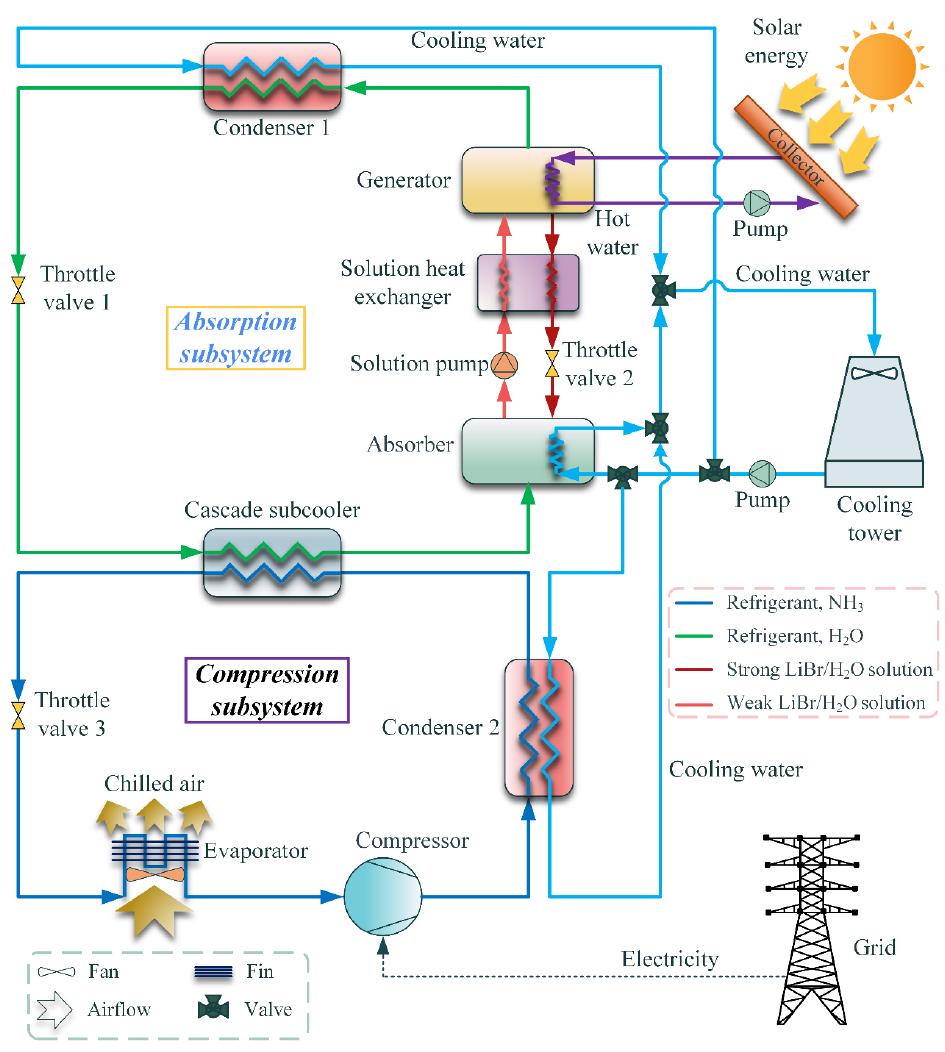
Figure 3. Schematic diagram of solar-assisted hybrid cooling system with cascade subcooling pro- cess.